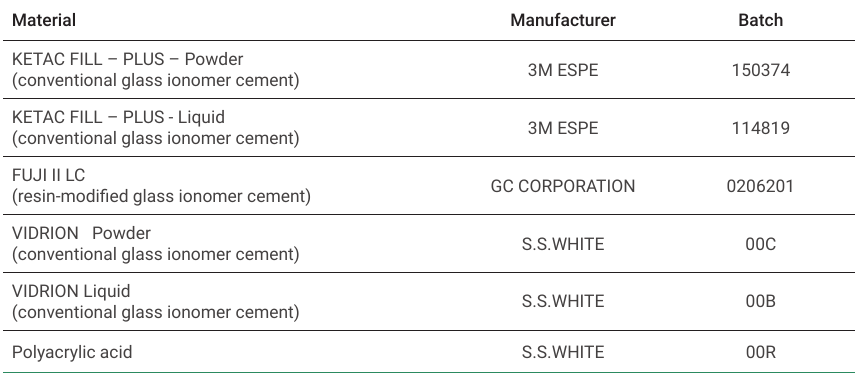
Table 1. Materials used and respective manufacturers and